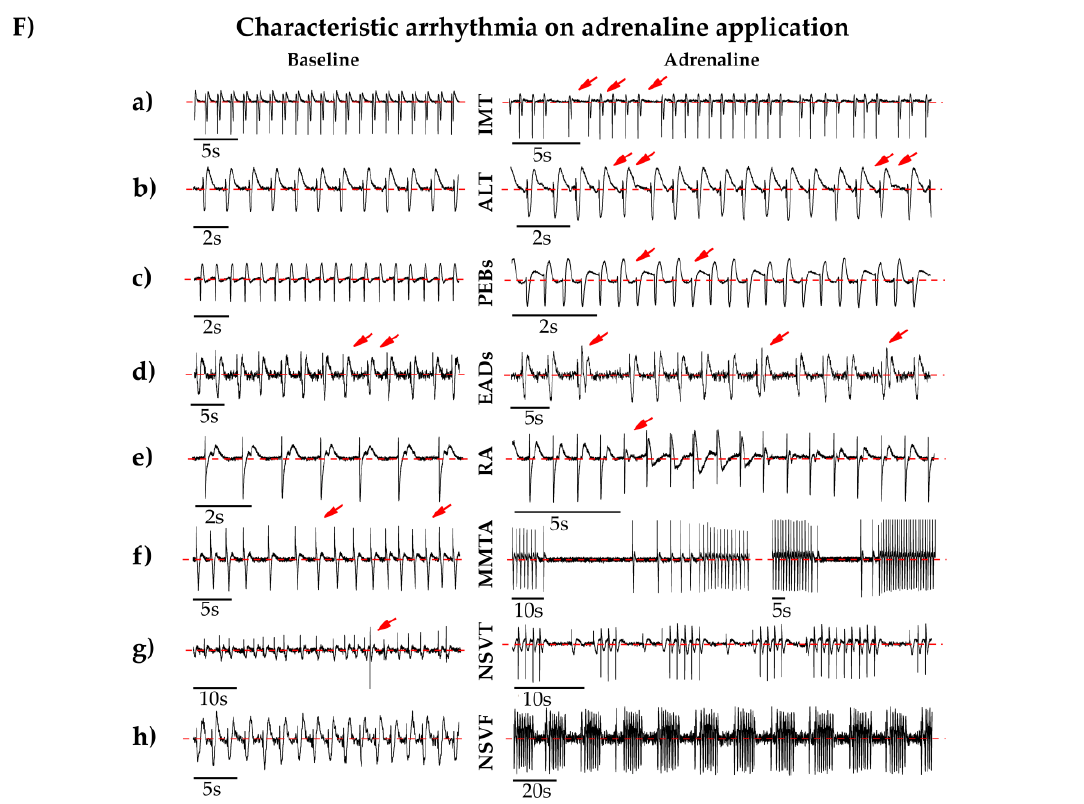
Figure 4. LQT2 hiPSC-CMs from the symptomatic patients presenting with increased arrhythmia Fig 4 on adrenaline application ( A ) Representative field potential traces from the control, the LQT2 asymptomatic and the symptomatic aggregates at baseline. The red arrows depict the end point of the repolarization duration, i.e., the field potential duration (FPD); the FPD was calculated from the start of the depolarization wave until the repolarization wave reaching the base. ( B , C ) The scatter-dot plots show the beat rate and the corrected field potential durations (cFPDs) from the control, the LQT2 asymptomatic and the symptomatic (labelled as (C,A and S with black, red and blue colors respectively), the boxes show the mean and SEM, for n = 62, 46, 38, respectively, for both the plots. ( D ) Percentage of aggregates showing arrhythmia at baseline, vehicle and under 100 nM, 300 nM, 600 nM and 1 µ M adrenaline application; n numbers for the control, the LQT2 asymptomatic and the symptomatic; Bl-Veh n = 20, 19, 20, Bl–Adr100nM n = 22, 17, 22, Bl-Adr300nM n = 20, 16, 23, BL-Adr600nM n = 23, 19, 22 and BL-Adr1 µ M n = 24, 18, 21, respectively. ( E ) Comparison of the types of arrhythmia observed at baseline and under adrenaline (types elaborated below). ( F ) Representative field potentials and characteristic arrhythmia observed in the control, the LQT2 asymptomatic and the symptomatic hiPSC-CM aggregates at baseline and after the application of adrenaline. ( a ) IMT = irregular monomorphic tachycardiac-like arrhythmia and variation of field potential beats, ( b ) ALT = alternans, ( c ) PEBs = premature ectopic beats, ( d ) EADs = early after polarization-like arrhythmia, ( e ) RA = Repolarization abnormality with monomorphic arrhythmia ( f ) MMTA = Monomorphic triggered activity-like arrhythmia ( g ) NSVT = Non-sustained ventricular tachycardia-like arrhythmia, ( h ) NSVF = Non-sustained ventricular fibrillation-like arrhythmia. The red arrows point to distinguish the types of arrhythmia for clarity